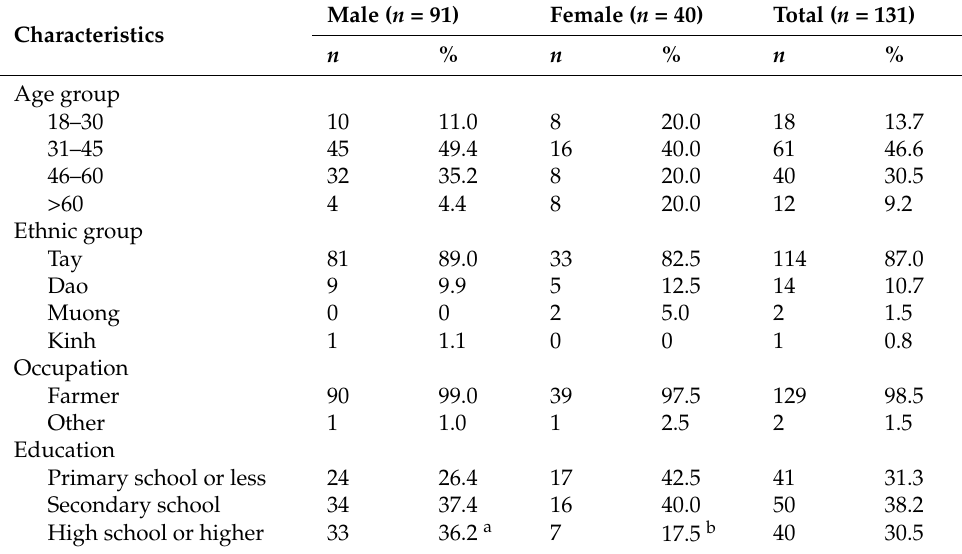
Table 4. Demographic information of